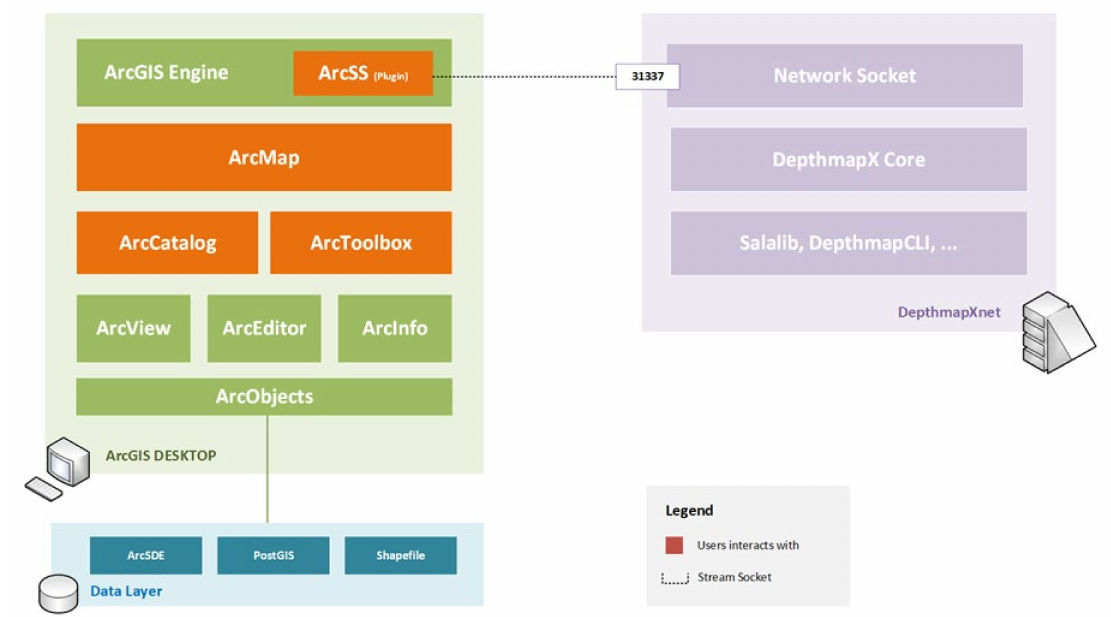
Figure 1. System